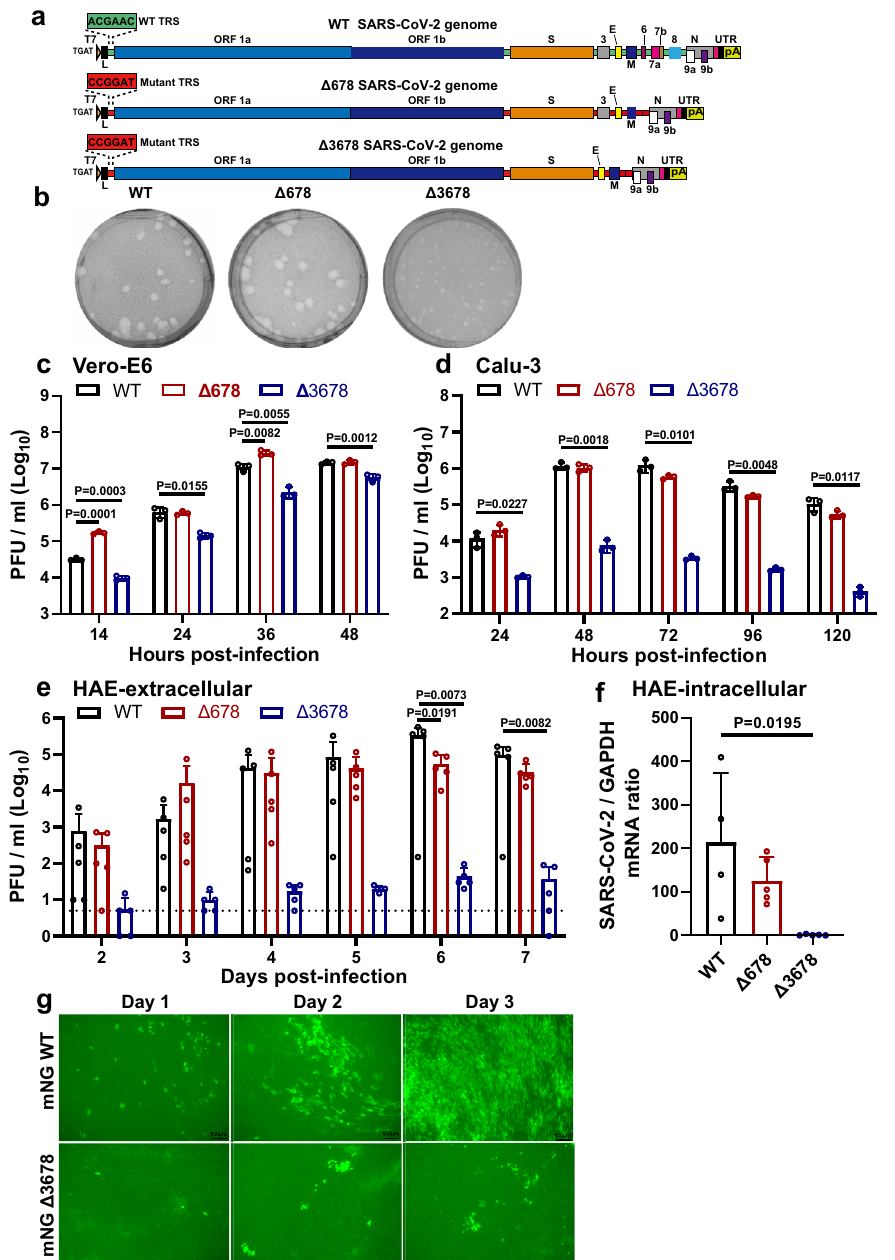
Fig. 1 | Attenuation of Δ 3678 SARS-CoV-2 in cell culture. a Scheme diagram for theconstructionof Δ 678and Δ 3678SARS-CoV-2.Thedeletionswereintroducedto the backbone of USA-WA1/2020 strain. Green and red boxes indicate the original andmutatedTRSsequences,respectively.T7T7promoter,Lleadersequence,TRS transcription regulatory sequences; ORF open-reading frame, E envelope glyco- protein gene, M membrane glycoprotein gene, N nucleocapsid gene, UTR untranslated region, pA poly A tails. b Plaque morphologies of recombinant WT, Δ 678, and Δ 3678 viruses. Plaque assays were performed on Vero-E6 cells and stained on day 2.5 post-infection. c – e Replication kinetics of WT, Δ 678, and Δ 3678 SARS-CoV-2s on Vero-E6 ( c ), Calu-3 ( d ), and HAE ( e ) cells. WT, Δ 678, and Δ 3678 viruseswereinoculatedontoVero-E6,Calu-3,andHAEcellsatMOIsof0.01,0.1,and 2,respectively.Aftera2-hincubation,thecellswerewashedthreetimeswithDPBS and continuously cultured under fresh 2% FBS DMEM. Culture supernatants were measured for infectious virus titers using plaque assays on Vero-E6 cells.